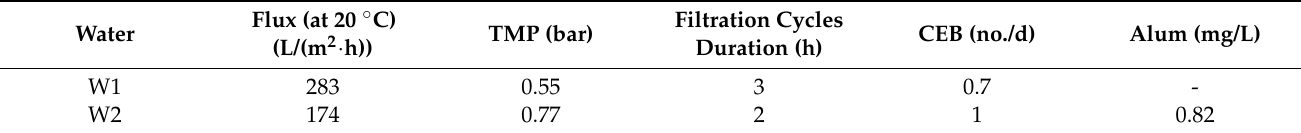
Table 5. Optimized (Alum)/MF operational conditions [20] considered for the cost analysis. Water